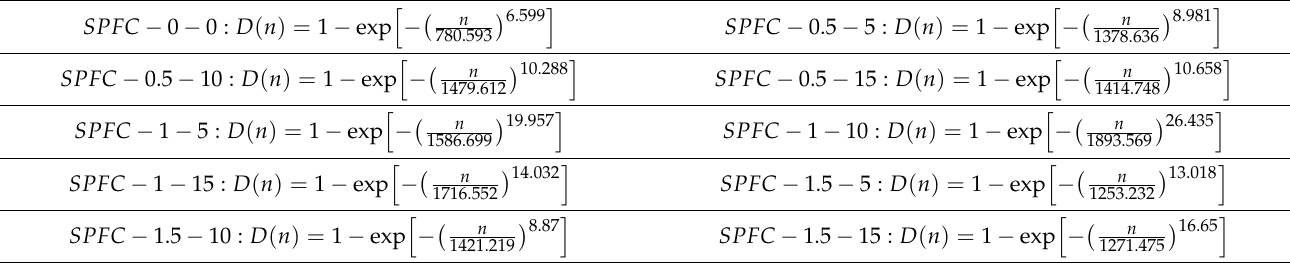
Table 7. SPRC impact-damage-evolution